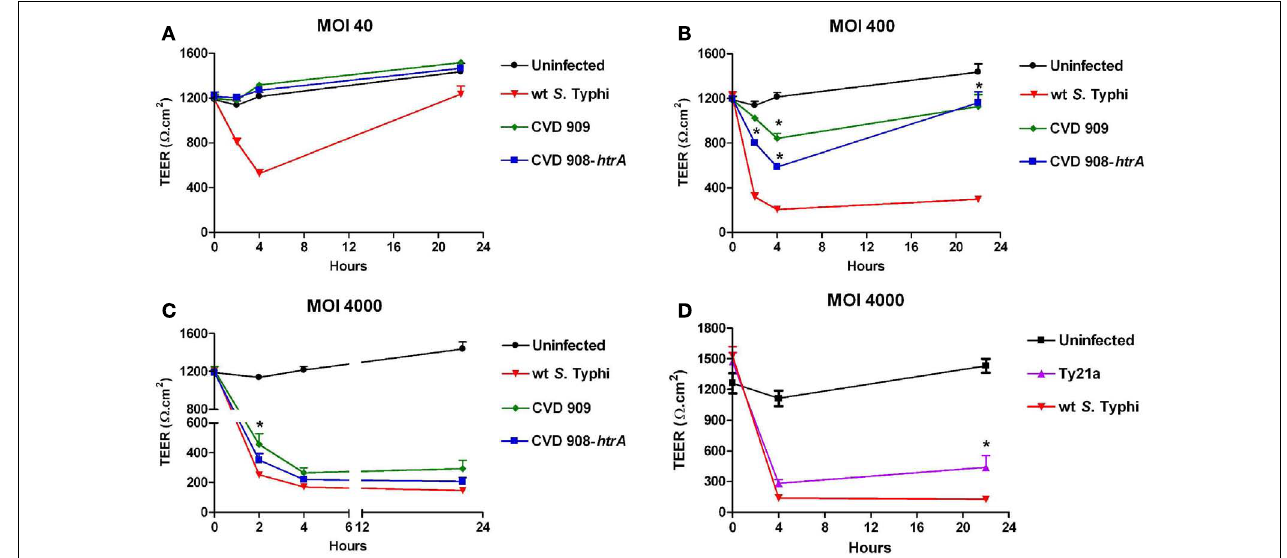
Ty21a applied apically at a MOI of 4000:1. Data are expressed as means ± SEM for triplicate samples for all conditions tested.These results are representative of three experiments with similar results. Statistical comparisons over wild-type S .Typhi at the same time point; * p < 0.05